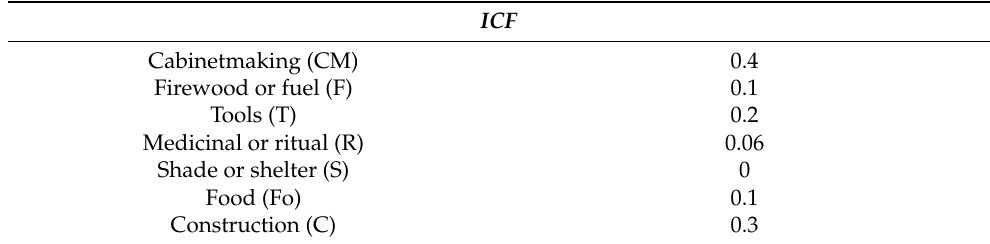
Table 3. Informant Consensus Factor ( ICF )